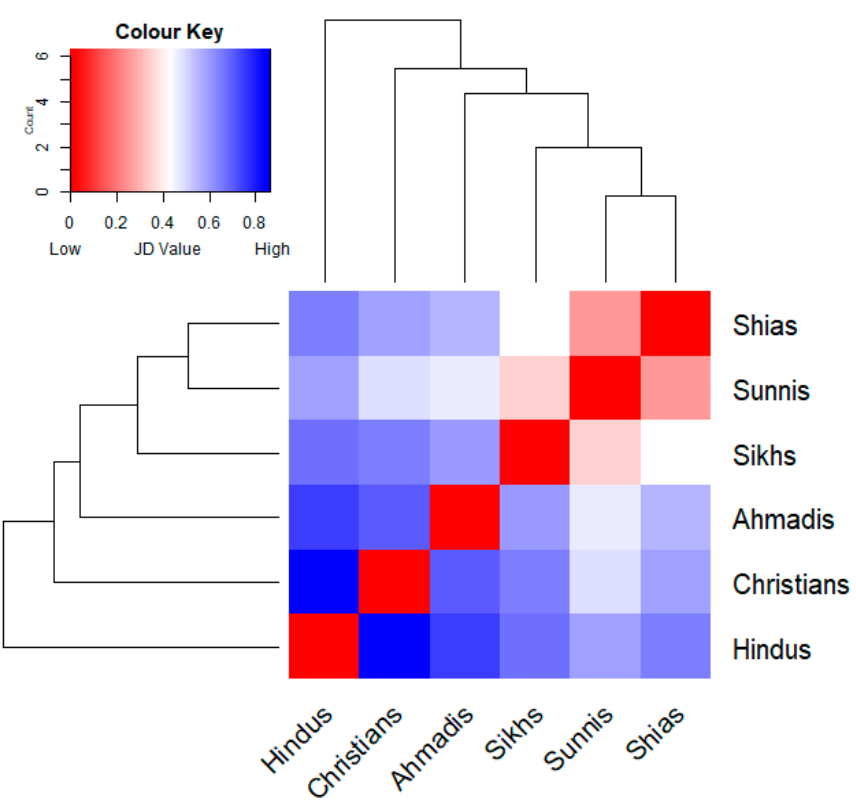
Figure 7. Hierarchical clustering tree coupled with heat map depicting Jaccard Dissimilarity Indices calculated by comparing the wild food plants quoted by the six considered groups.